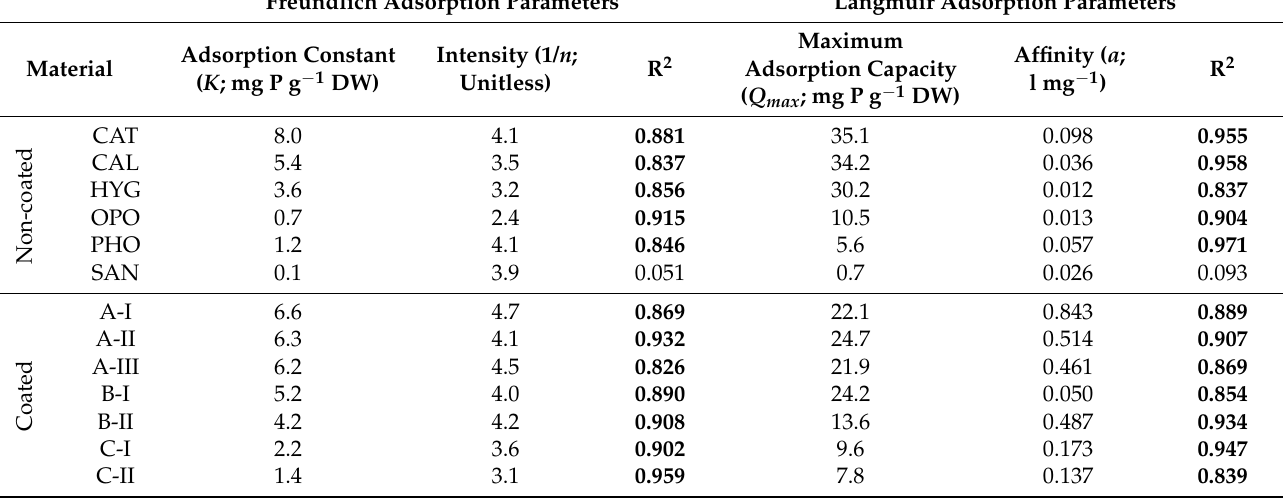
Table 5. Freundlich and Langmuir adsorption parameters for non-coated and coated materials tested using sorption isotherm experiments. Freundlich adsorption parameters ( q = K × C eqn ) with adsorption constant and sorption